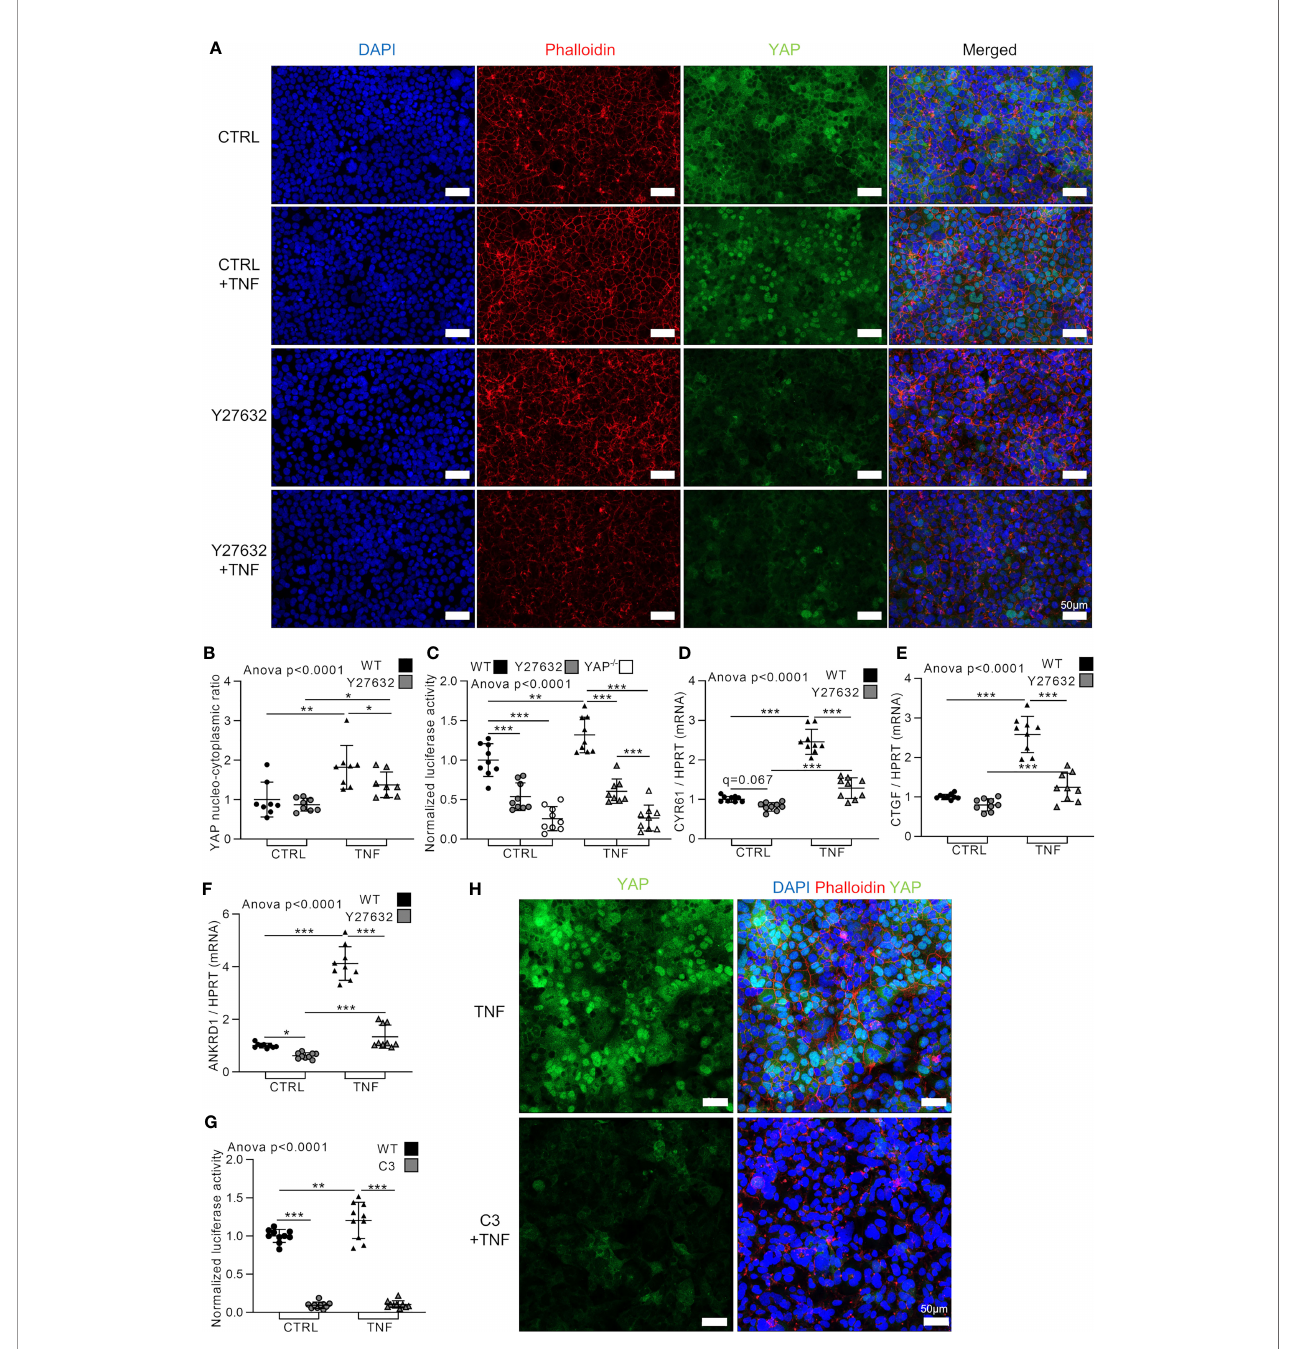
FIGURE 2 | TNF activates YAP through Rho family of GTPases. HEK293 were cultured as described in Figure 1 . Cells were pre-treated with Y27632 at 10 µM or C3 exoenzyme cell permeable at 2 µg/ml for 2 h before adding TNF for 48 h [24 h in (C) and (G) ]. (A) Representative airyscan confocal z-stack max intensity images of YAP (immuno fl uorescence (IF) technique, green), phalloidin (actin, red), DAPI (nucleus, blue), and merged images. (B) Corresponding IF quanti fi cation of YAP nucleo-cytoplasmic ratio. (C) and (G) Luciferase reporter assay of TEAD transcription factor activity. (D – F) RT-qPCR results for CYR61 (D) , CTGF (E) and ANKRD1 (F) , results were normalized to HPRT expression. (H) Representative airyscan confocal z-stack max intensity images of YAP [immuno fl uorescence (IF) technique, green] alone or with phalloidin (actin, red) and DAPI (nucleus, blue). For confocal images, luminosity and contrast were enhanced identically for each image for clarity purpose. Results are representative of three independent experiments with 2 to 3 biological replicates for each experiment (n = 6 to 9 per group) with T-test or one- way ANOVA test and FDR corrected for multiple comparisons post hoc tests performed between conditions: *p < 0.05; **p < 0.01; ***p < 0.001. Data are expressed as fold change vs. control and presented as individual values with mean ±